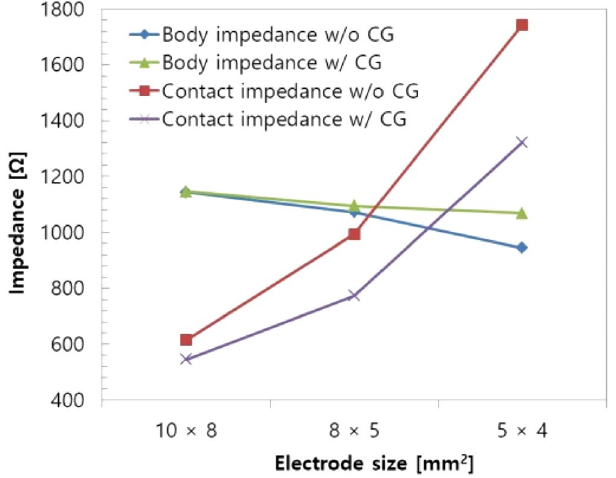
Figure 2. Contact resistance vs. electrode area and state of skin–electrode contact interface ( CG conductive gel, w/o without, w/ with).